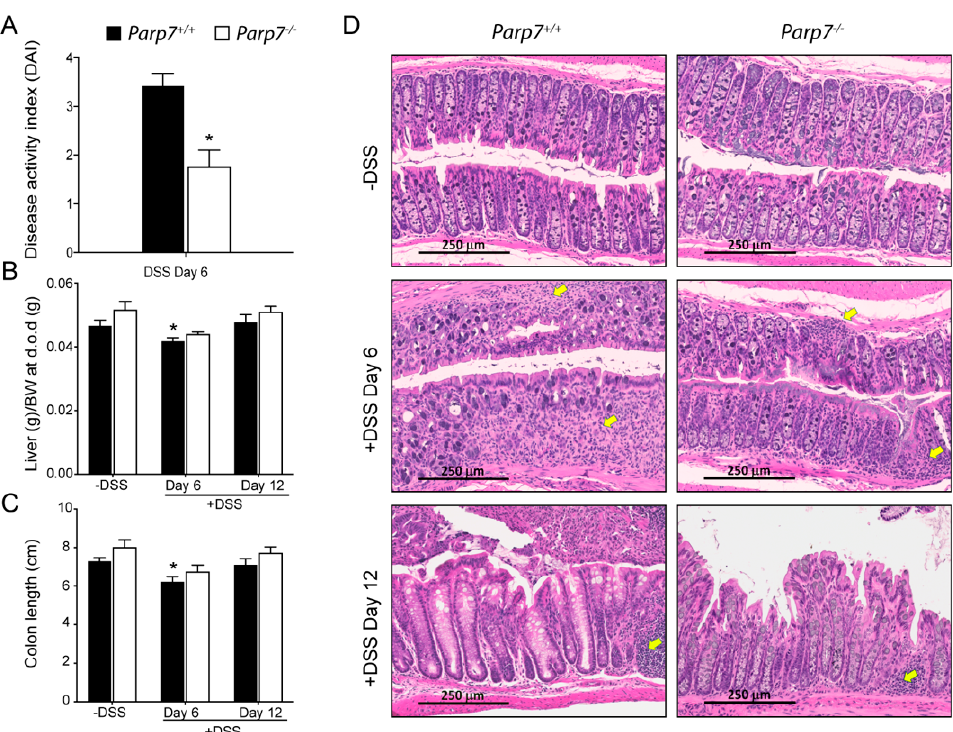
Figure 3. Reduced colitis symptoms in Parp7 − / − mice. ( A ) Parp7 − / − mice present lower intestinal inflammation symptoms than Parp7 +/+ mice as indicated by a reduced disease activity index (DAI) on day 6 of DSS treatment. * p < 0.05 student’s t-test. Parp7 +/+ mice have a greater reduction in colon length ( B ) and liver weight ( C ) on day 6 of DSS treatment compared with Parp7 − / − mice. * p < 0.05 two-way ANOVA compared with genotype-matched and DSS treated mice. (D) Parp7 − / − mice exhibit less tissue damage and immune cell infiltration than Parp7 +/+ mice. Representative H&E staining of colon section after 6 days of exposure to 2% DSS in drinking water and after water recovery. The yellow arrows indicate immune cell infiltration.